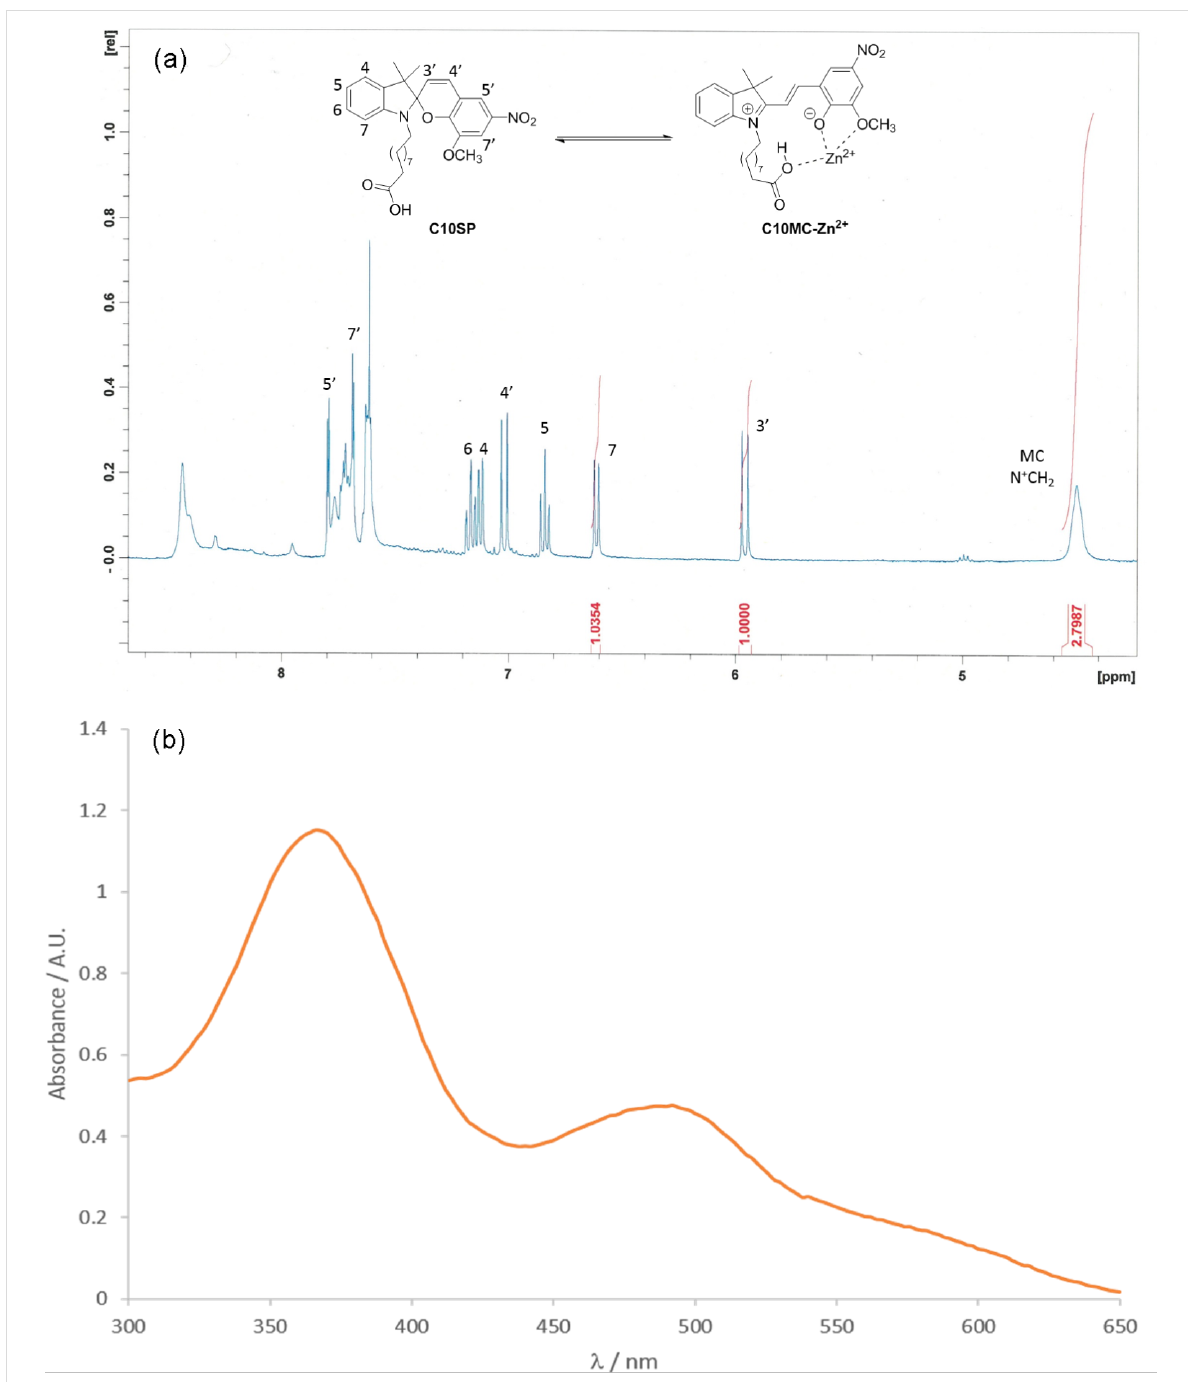
Figure 3: Example spectra illustrating binding studies of spiropyrans with M 2+ . (a) 1 H NMR spectrum of C10SP (10 mM) and Zn(NO 3 ) 2 ·6H 2 O (2 mM) in CD 3 CN–H 2 O (99.9% v/v) after 18 h in darkness. Peaks corresponding to H nuclei within the spiropyran isomer are labelled; aromatic peaks from the merocyanine–Zn 2+ complex are broad and unassigned. SP:MC was estimated by comparison of integral values from SP 3 ′ -H and MC (N + CH 2 )/2 (as shown in red). (b) UV-visible absorbance spectrum of C10SP (0.1 mM) and Zn(NO 3 ) 2 ·6H 2 O (0.02 mM) in CD 3 CN/CH 3 CN–H 2 O (99.9% v/v) with MC–Zn 2+ prominent at 495 nm. [ C10MC –Zn 2+ ], derived from (a), was used to calculate of ε for this absorbance.